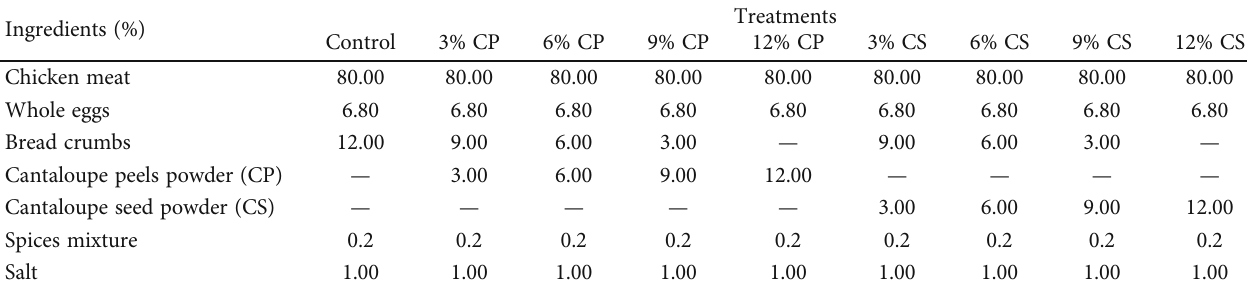
Table 1: Formula of chicken patties (g) prepared with di ff erent ratios of cantaloupe peel and seeds powder. Ingredients (%)